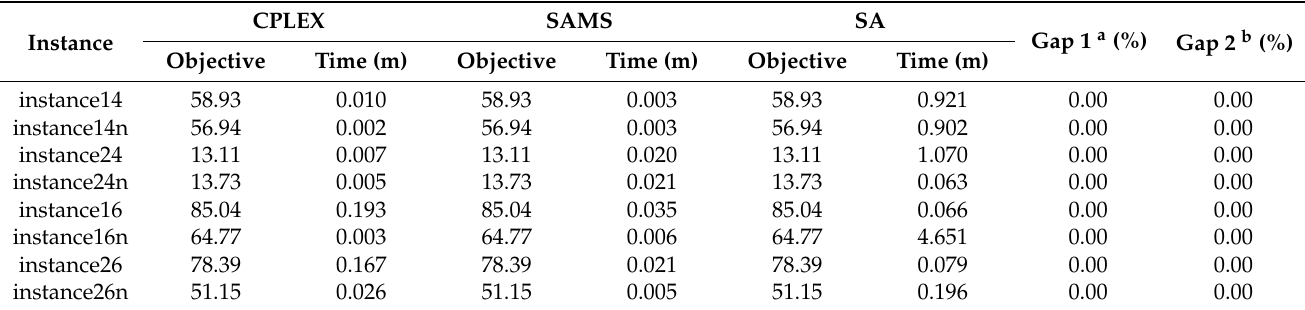
Table 2. Comparison between CPLEX, proposed SAMS, and SA solution for SARP small instance.